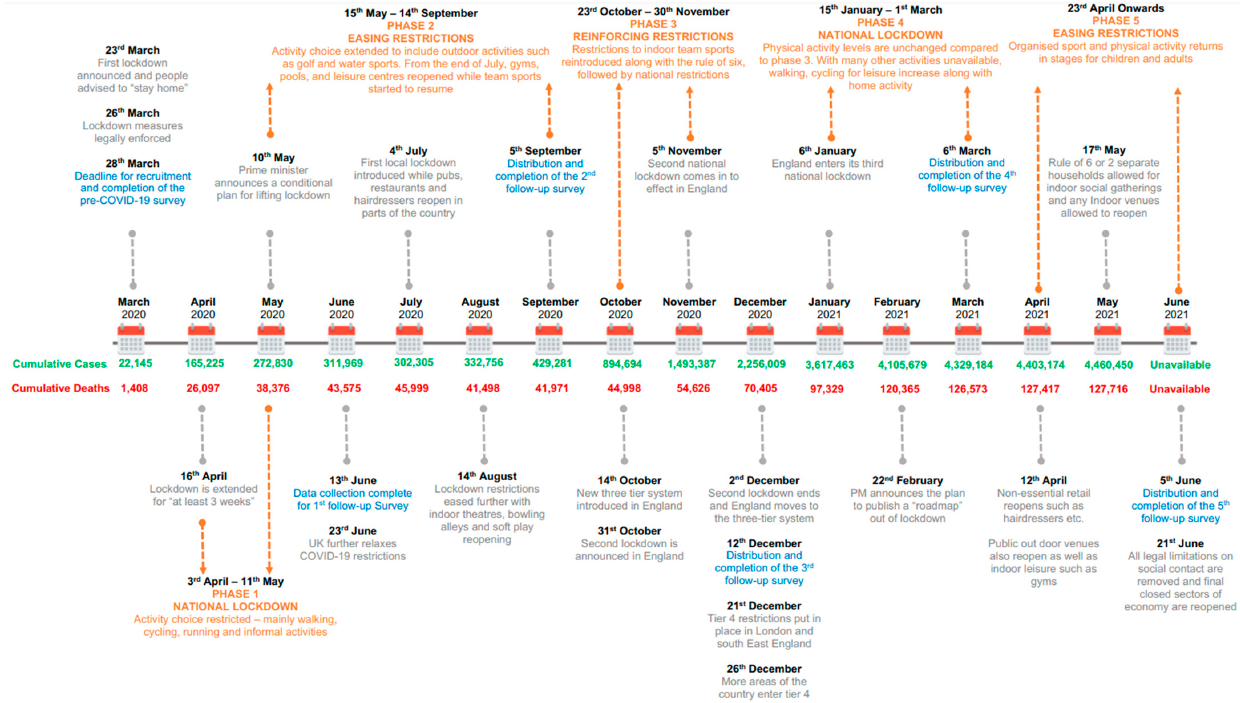
Figure 1. Overview of COVID-19 events in the UK between March 2020 and June 2121. Reprinted from [14].